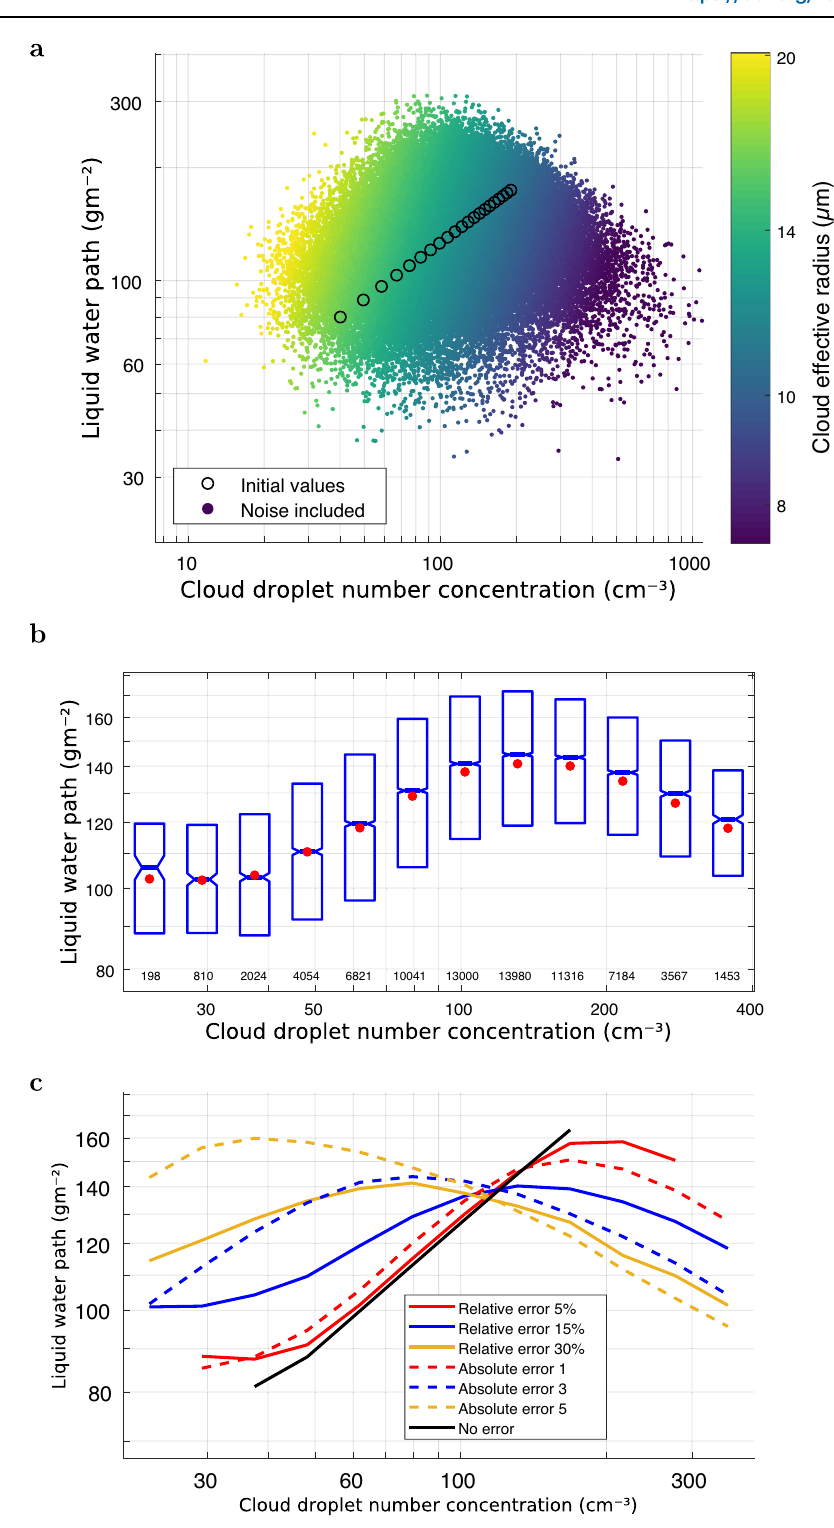
Fig. 2 | Simulated liquid water path (LWP) against cloud droplet number con- centration(CDNC)forthecaseofcloudopticaldepth(COD)andcloudeffective radius (CER) error of 15%. dlnCDNC = dlnCCN=0 : 8 and dlnLWP/dlnCDNC=0.5 were prescribed. The initial values of 100cm − 3 for cloud condensation nuclei (CCN), 40cm − 3 forCDNC and80gm − 2 forLWPwere assumed. a TheCERisshown as color bar. The circles show the imposed relationship in the LWP adjustment